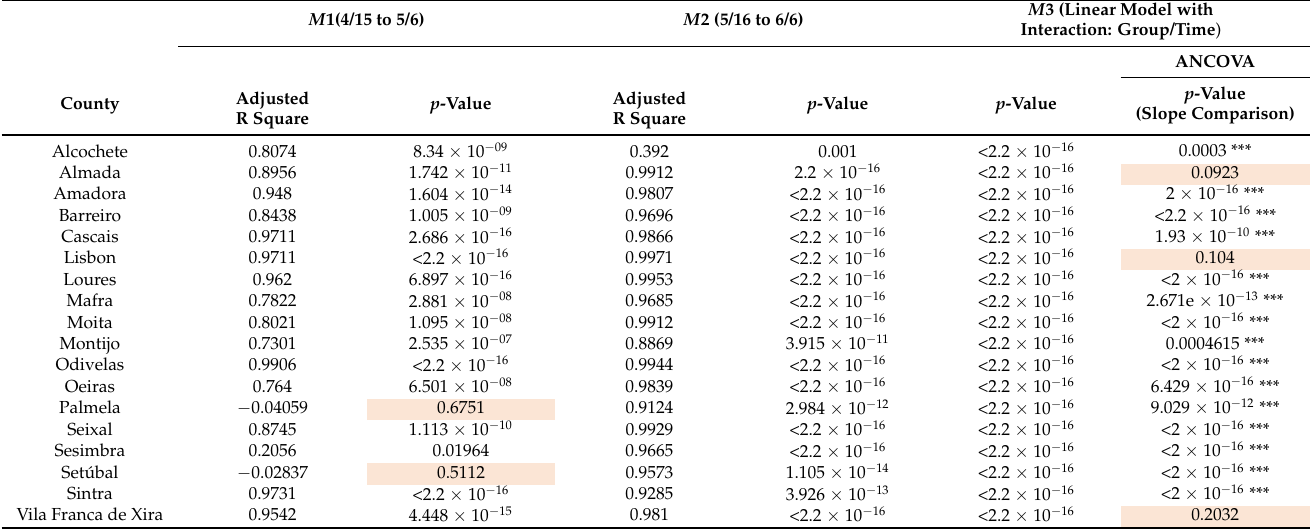
Table 2. Results from goodness-of-fit tests of M 1 and M 2 linear models (8) and their slope homogene- ity, for each